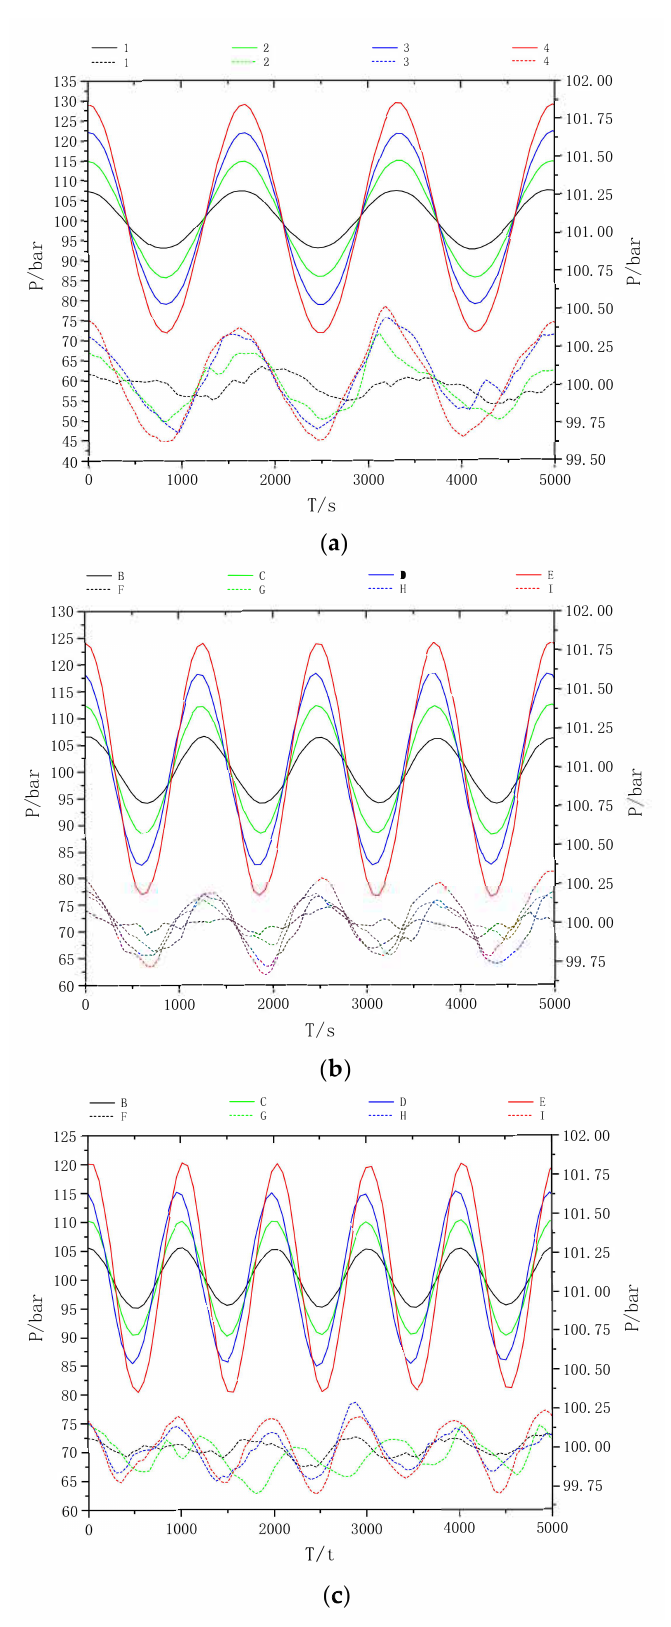
Figure 19. Schematic of accumulator experiment exploration. ( a ) Pressure wave absorption effect drawing (0.6 Hz); ( b ) pressure wave absorption effect drawing (0.8 Hz); ( c ) pressure wave absorption effect drawing (1 Hz). 1, 2, 3, and 4 represent pressure fluctuations of different amplitudes while 5, 6, 7, 8 represent the performance control experiment of the accumulator to resume pressure